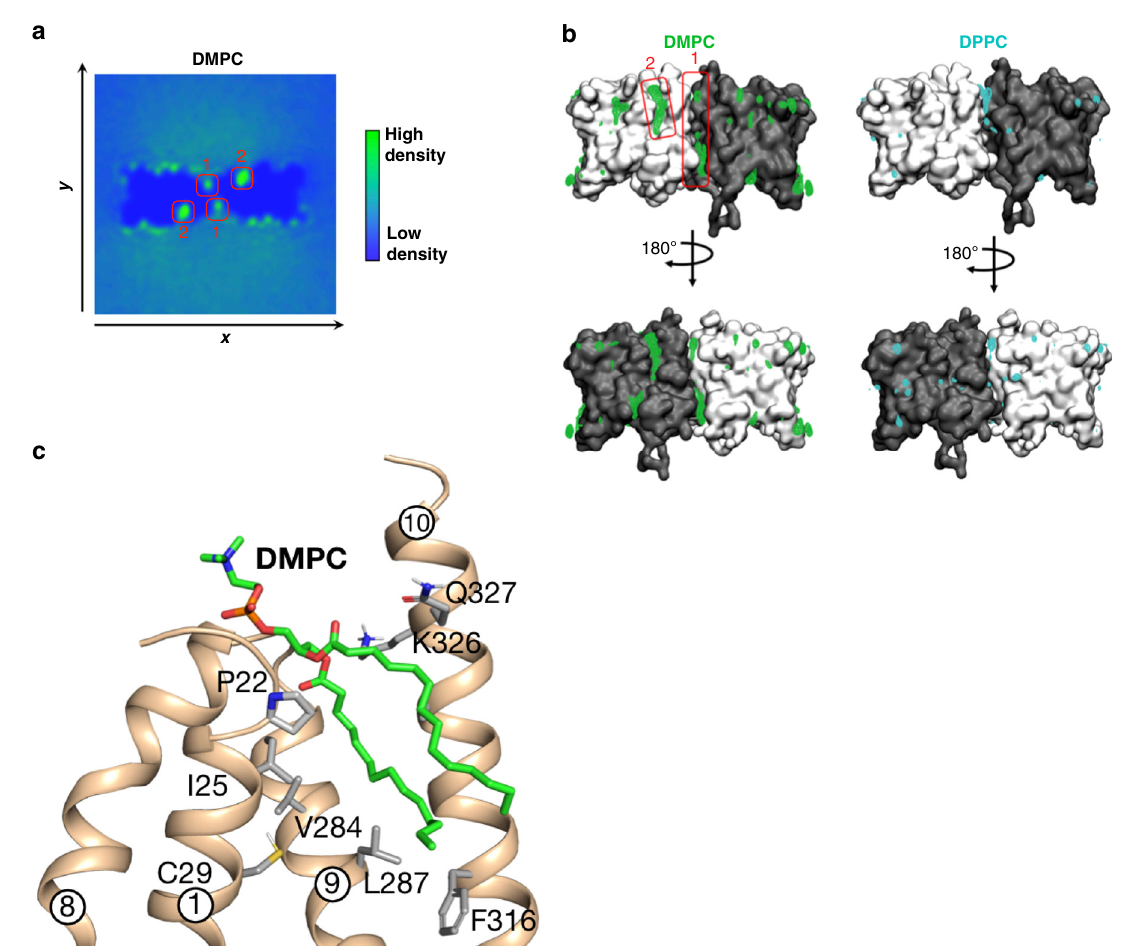
Fig. 5 Identi fi cation of short chain lipid binding site. a Density plot of DMPC lipids around the Vrg4 dimer. In addition to the primary lipid binding sites on the dimer interface (labelled 1), secondary binding sites can be observed (labelled 2) (green densities). b Views of Vrg4, with the densities from 4c and 5a shown as coloured mesh. The protein is shown as surface, with each Vrg4 monomer coloured as white or grey. The primary binding site – marked ‘ 1 ’ in the top left view – is occupied by both DMPC and DPPC. A secondary site – marked ’ 2 ’ – is exclusively occupied by DMPC. c View of the bound DMPC lipid in the secondary binding site, following 30 ns of atomistic simulation. Residues interacting with the lipid are indicated as sticks and labelled and helices are